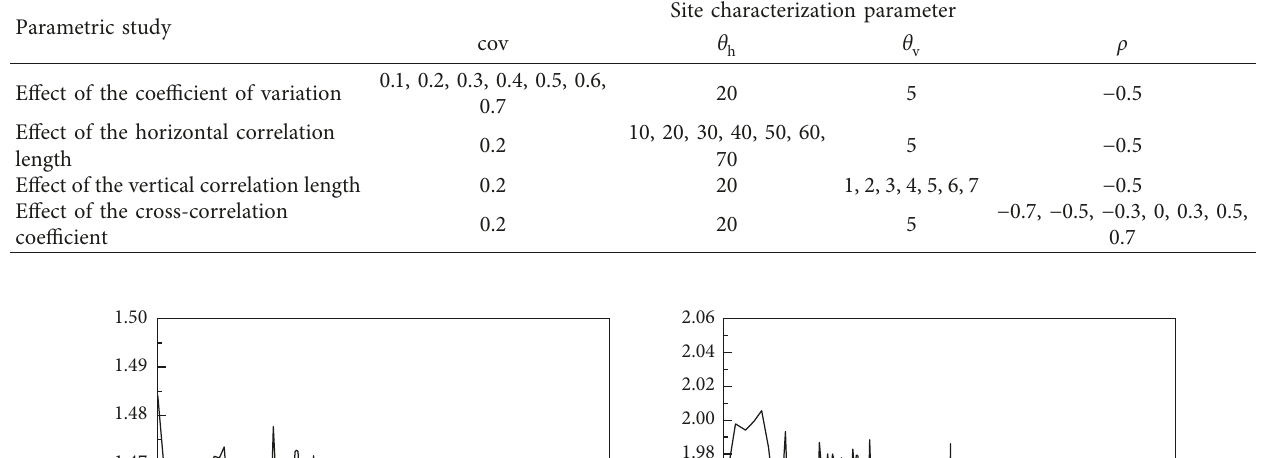
Table 2: Parameters used in the parametric studies.